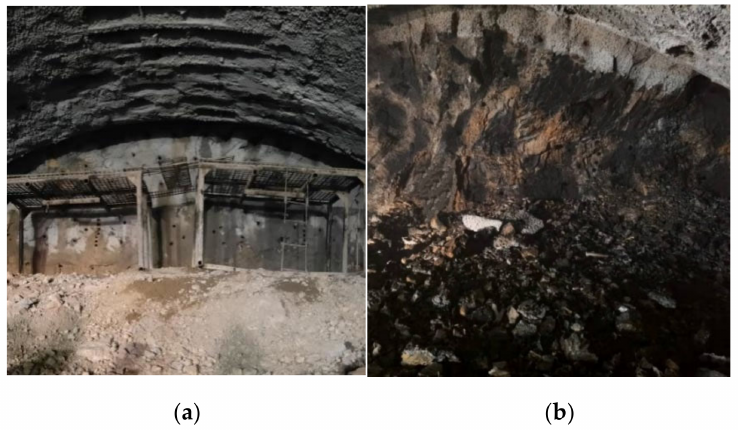
Figure 12. The comparison before and after rock mass cracking in test 4. ( a ) Tunnel face before rock mass cracking. ( b ) Tunnel face after rock mass cracking.